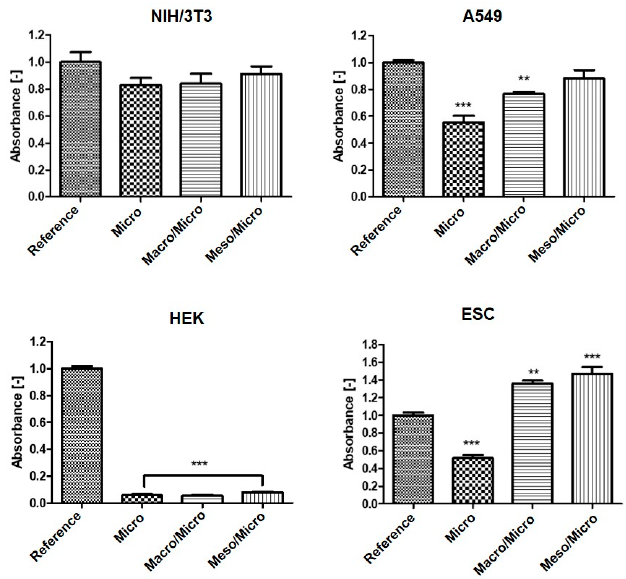
Figure 6. Quantification of initial growth/proliferation of different cell lines using MTT assay. NIH/3T3—fibroblasts, A549—human carcinoma cells, HEK—keratinocytes and ESC—embryonic stem cells. ANOVA with post hoc Tukey’s Multiple Comparison test was applied to determine any statistical differences between the samples; ** p < 0.01, *** p < 0.001.